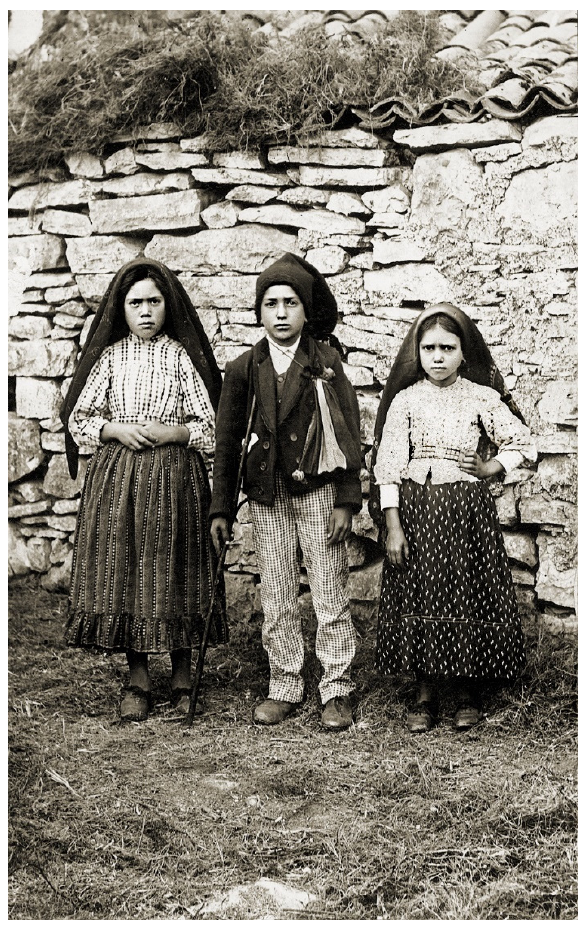
Figure 1. Lúcia Santos, Jacinta and Francisco Marto Photograph attributed to Joshua Benoliel, pub- lished in Ilustração Portuguesa no. 610, 29 October 1917. Source: https://upload.wikimedia.org/wik- ipedia/commons/c/c9/ChildrensofFátima.jpg, 9 August